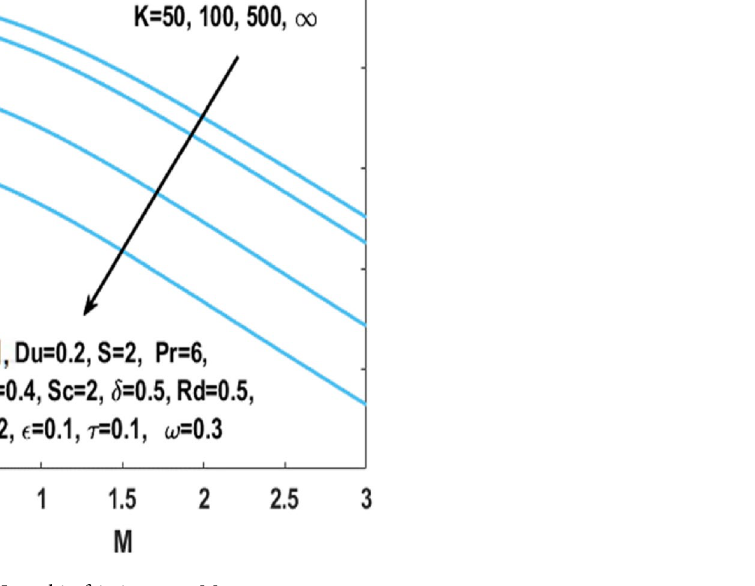
Figure 11. Impact of K on skin friction w.r.t M